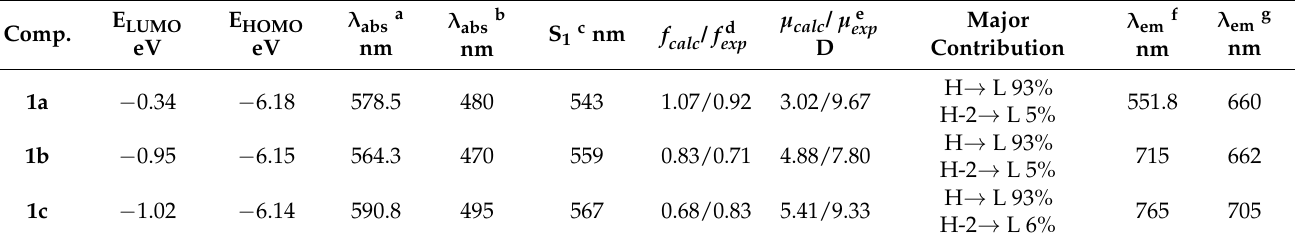
Table 4. Comparative experimental and computational photophysical parameters. Calculated energies of LUMO (E LUMO ) and HOMO (E HOMO ): a computational absorption maximum wavelength, b experimental absorption maximum wavelength, c experimentally obtained first excited singlet state S d computational oscillator strength of vertical absorption and 1 energy, experimental oscillator strength values, e computational and experimental transition dipole moment values, f computational emission maximum wavelength, and g experimental emission maximum